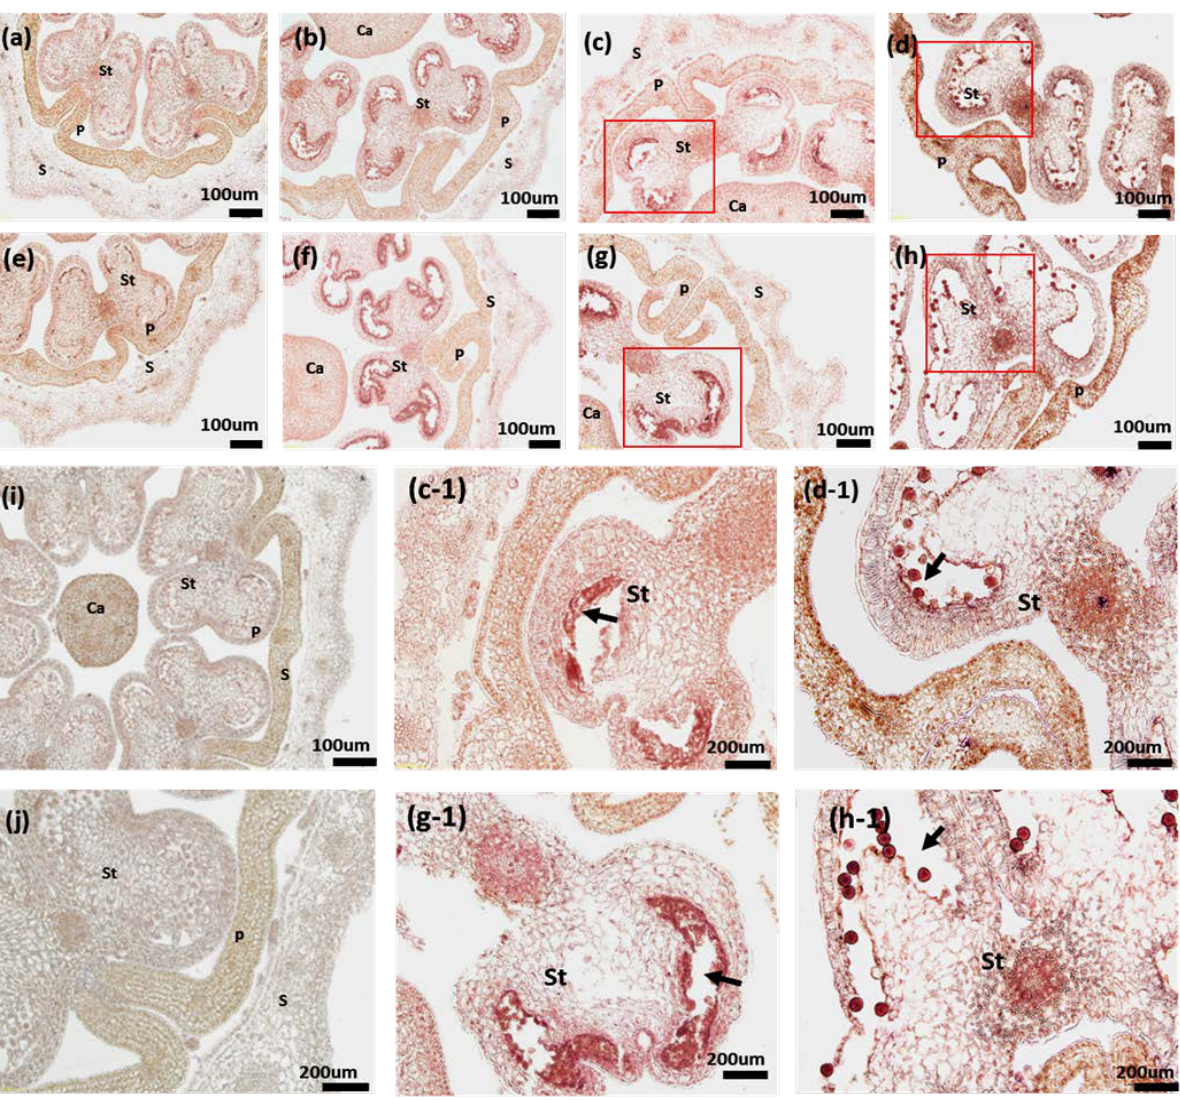
Figure 5. Expression of PAP3 during bud development of pepper fertile and CMS lines. Buds from different development stages were shown under the objective of 100× ( a – i ) and 200× ( j , c - 1 , d - 1 , g - 1 , h - 1 ), respectively; ( i , j ) were SP6 negative controls; ( a – d ) showed the four phases during bud development (tetrad, Early-or mid-uninucleate, late-uninucleate, binucleate) in CMS line; ( e – h ) showed the four phases during bud development (tetrad, early-or mid-uninucleate, late-uninucleate, binucleate) in restorer line; ( c - 1 , d - 1 , g - 1 , h - 1 ) were picked up and amplified form ( c , d , g , h ), respectively. PAP3 gene is expressed mostly in the specific organs in anther ( c - 1 , d - 1 , g - 1 , h - 1 ). Arrows indicate sites of anther. S, sepal; P, petal; St, stamen; Ca,